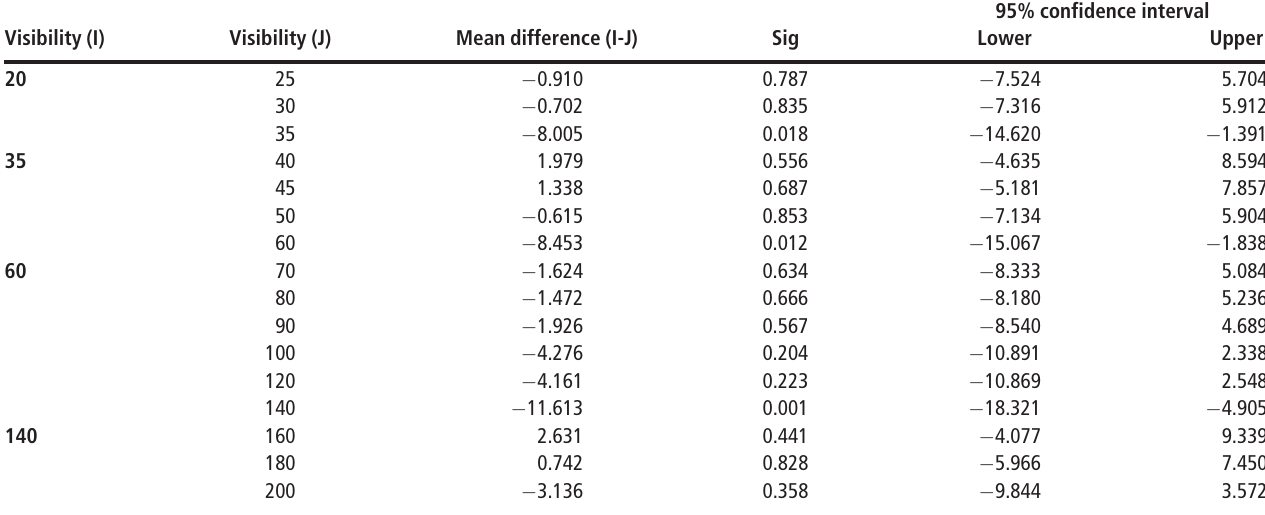
Table IV Multiple comparisons of the effect of visibility conditions on average speed at straight segment Visibility (I)